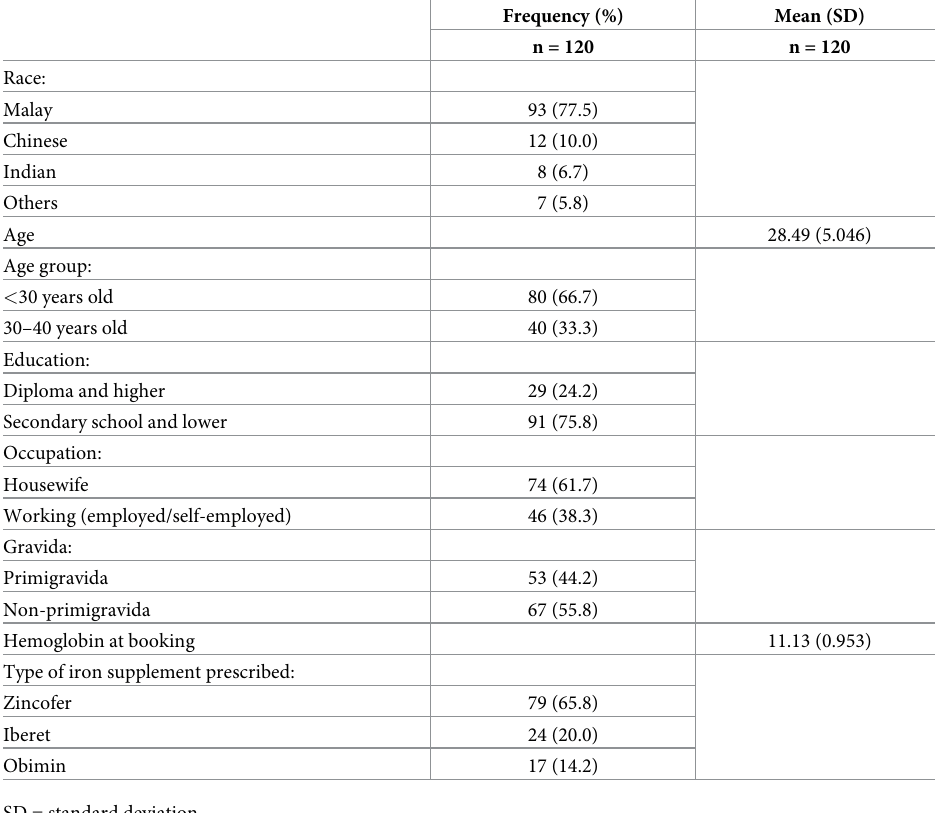
Table 2. Sociodemographic characteristics of